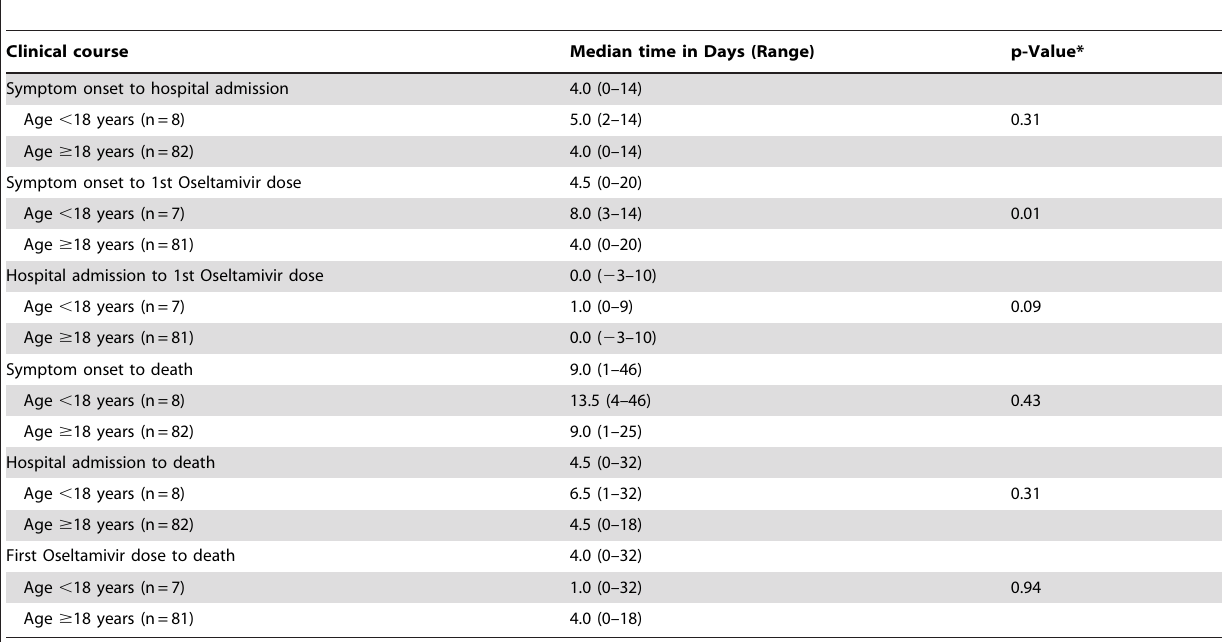
Table 3. Timing of antiviral therapy relative to clinical course of 90 influenza A (H1N1)pdm09 virus-associated pneumonia fatalities in Thailand for whom medical record reviews were conducted, May 2009-January